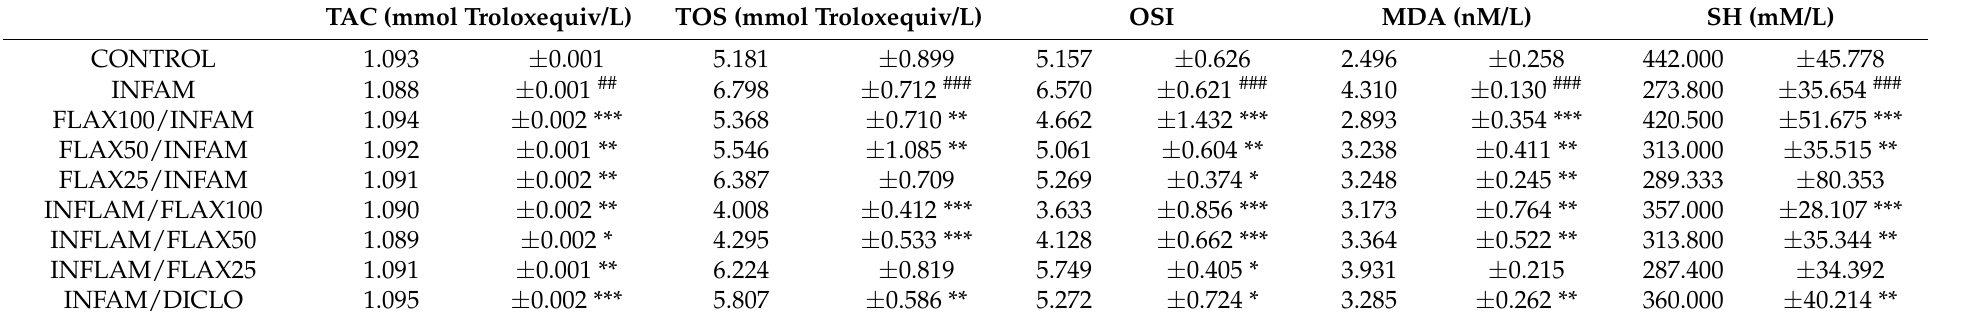
Table 2. Serum oxidative stress